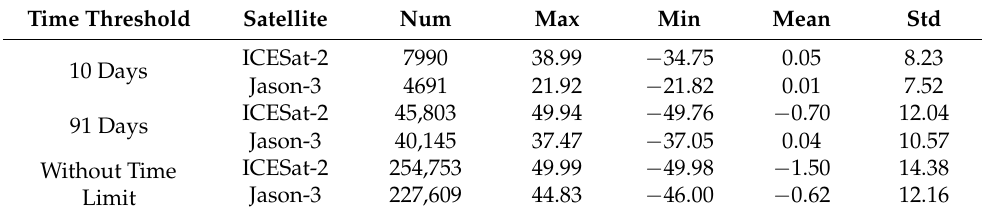
Table 2. Difference in SSHs at ICESat-2 and Jason-3 self-crossover points (Unit: cm). Time Threshold